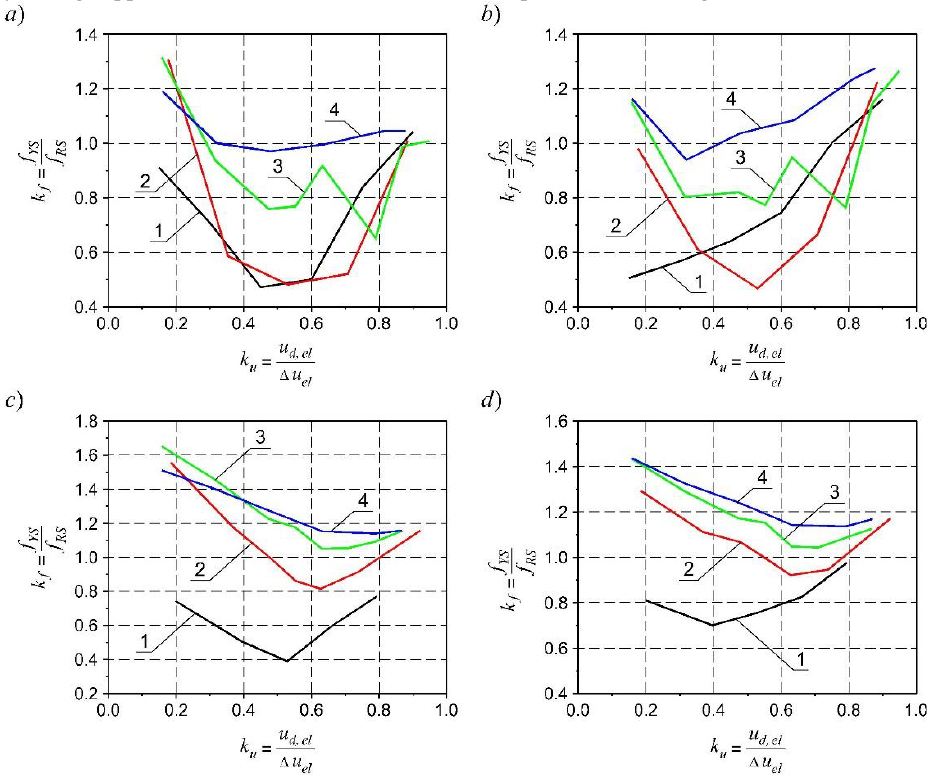
Fig. 9. Influence of value of supports displacements at transition to plastic phase on slab displacements: a – in section 2–2 at 2–2 with nonlinear stiffness distribution of supports on the sides of the slab; d – in section 1–1 with nonlinear stiffness distribution of supports on the sides of the slab; 1 – for 50000 kN/m/m g  ; 3 – for 1 el